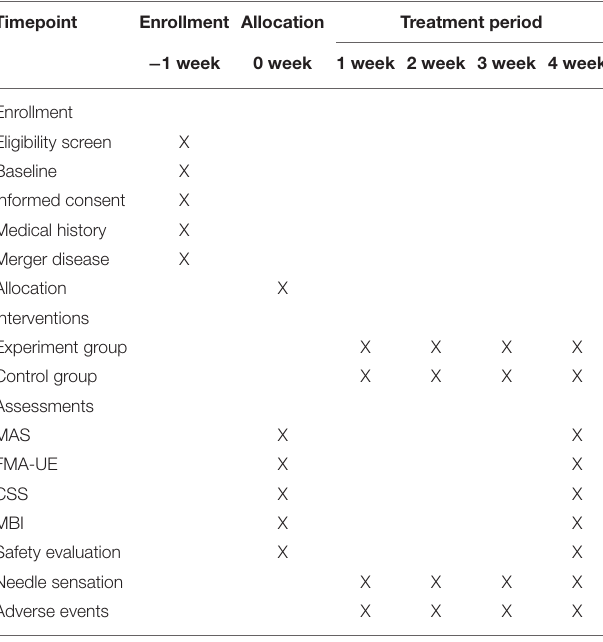
TABLE 1 | Qualification screening and informed consent was completed before the assignment.